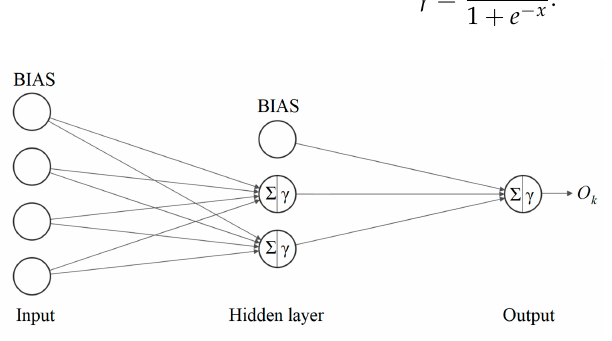
Figure 3. An example of MLP neural